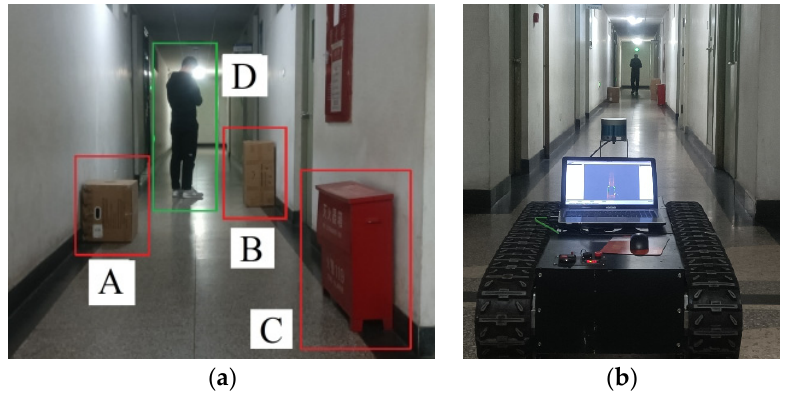
Figure 15. Scene 3: underground coal mine roadway simulated environment and experiment plat- form: ( a ) static obstacle and pedestrian; and ( b ) the whole scene and experiment platform.